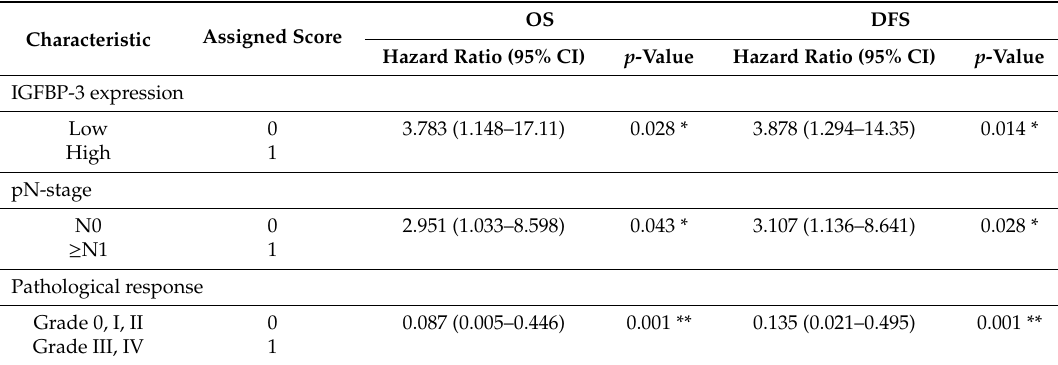
Table 2. Multivariate analysis of prognostic factors in patients with OSCC based on the Cox proportional hazards regression model and IGFBP-3